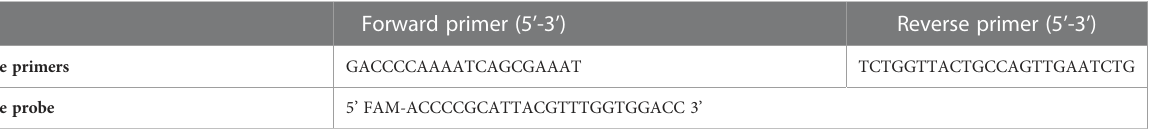
TABLE 1 SARS-CoV-2 Nucleocapsid primers and